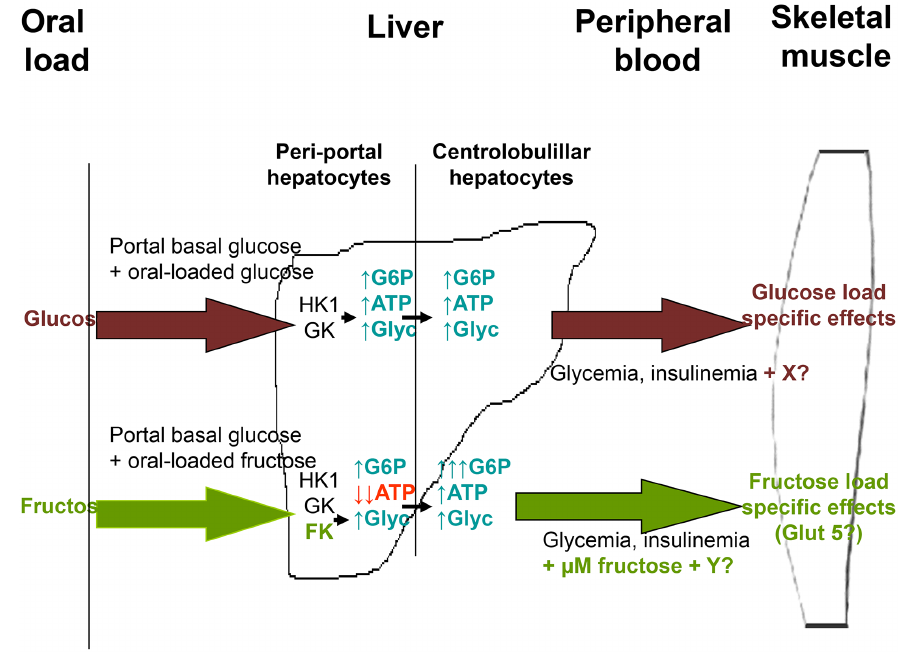
Figure 4. Diagram explaining the postulated hypothesis given to explain the specific effects of fructose and glucose on the overall function of liver and skeletal muscle cells after ingestion of/incubation with these sugars. Following this hypothesis, peri-portal hepatocytes respond to glucose or fructose in a specific manner, depending on the sugar-specific changes that intracellular G 6P and ATP levels undergo in these cells and, perhaps, other unknown signalling mechanisms. The response of these cells is communicated to other hepatic cells and the liver as a whole signals peripheral tissues; this signalling, which is probably based on the presence or absence of micromolar concentrations of fructose in circulating blood, in addition to other putative, unknown signalling mechanisms, indicates that the circulating metabolites derive from either glucose or fructose. Peripheral tissues, like skeletal muscle, would then respond in a specific manner to these signals by changing the phospho- dephosphorylation levels of several key proteins, thus inducing an alteration in the physiology of these